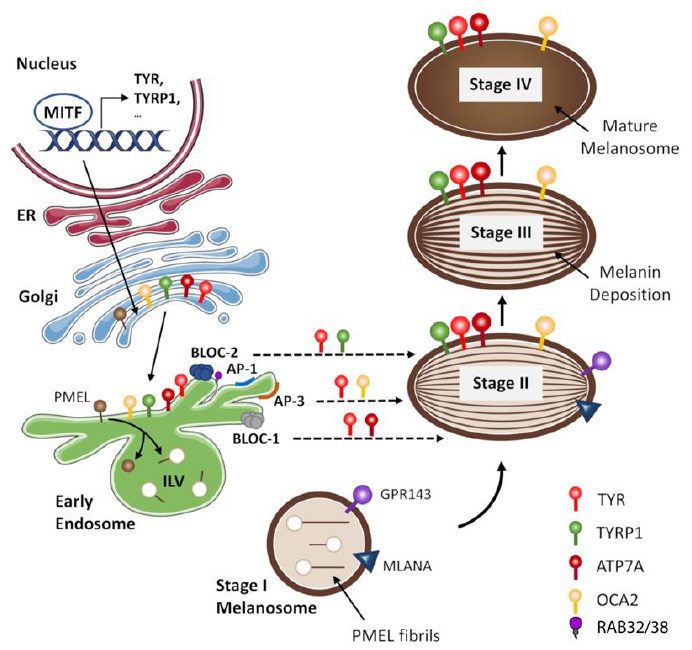
Figure 3. Schematic representation of the biogenesis of an eumelanosome. The development and maturation of melanosomes proceeds through four stages, which can be grouped into two unpig- mented (stages I and II) and pigmented (stages III and IV) steps. Melanosomes are assembled in the perinuclear region, near the Golgi stacks, receiving the enzymatic and structural proteins required for melanogenesis. In Stage I, immature melanosomes are spherical, vacuolar domains of early en- dosomes that harbour intralumenal vesicles formed by invagination of the limiting membrane. In Stage II, pre-melanosomes are characterized by a fully formed melanosome matrix, where PMEL fibrils are organized into arrays of parallel sheets, transforming the spherical Stage I melanosomes into elongated, elliptical organelles. The formation of PMEL fibrils segregates the melanosomal from the endosomal pathways, which seems to involve GPR143 and MLANA. In Stage III, melanogenesis starts with the pigment being regularly and uniformly synthesized on the fibrillar matrix, which causes the darkening and thickening of the matrix fibrils. By Stage IV, the melanosomes are satu- rated with melanin, in this case predominantly eumelanin, and the internal fibrillar structure be- comes completely masked by the pigment; the mature melanosomes are ready to be transferred to adjacent keratinocytes. Melanogenic proteins are loaded into vesicular or tubular carriers for deliv- ery into melanosomes through a process involving the fusion of their limiting membranes. The sort- ing and transport of melanogenic proteins involve multisubunit protein complexes, such as AP-1 and AP-3, as well as BLOC-1 and BLOC-2. AP-1/3: adaptor-related protein complex 1/3; ATP7A: ATPase copper transporting alpha; BLOC-1/2: biogenesis of lysosomal organelles complex 1/2; ER: endoplasmic reticulum; GPR143: G protein-coupled receptor 143; ILV: intralumenal vesicle; MITF: microphthalmia-associated transcription factor; MLANA: protein melan-a; OCA2: oculocutaneous albinism 2 protein; PMEL: premelanosome protein; TYR: tyrosinase; TYRP1: tyrosinase related pro- tein 1.